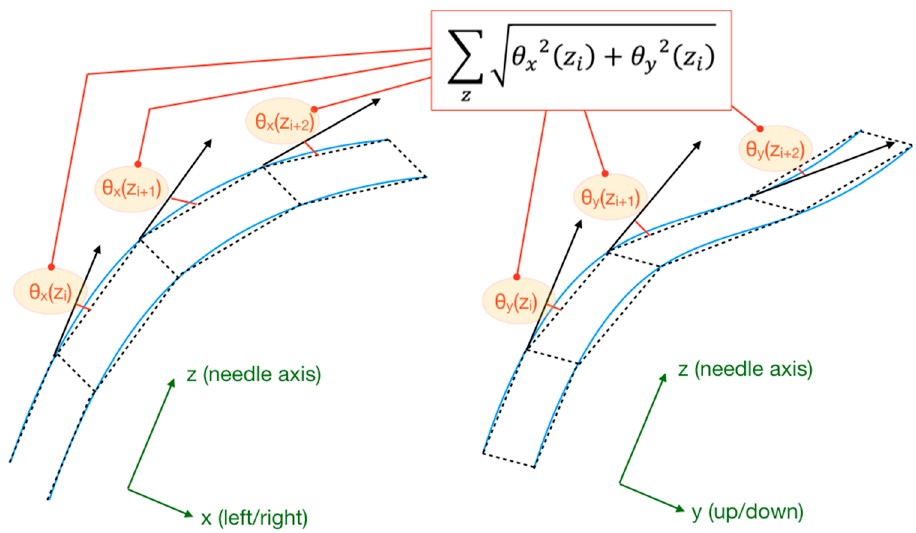
Figure 4. Geometrical visualization of the sum of the projected bending angles (SPBA), which is the metric used to evaluate the bending pattern for each experiment. The figure shows how each local bending angle contributes to the SBPA calculation for the needle section under investigation.